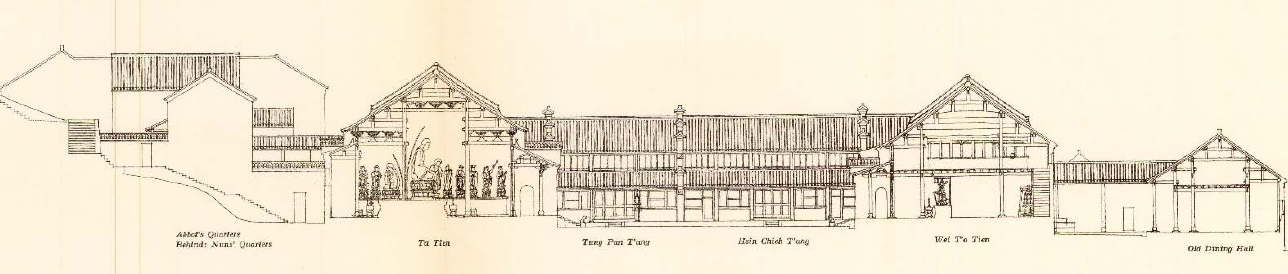
Figure 10. Section of Longchang Monastery, Showing the Main Hall, the Main Courtyard and the Hall of Weituo (Prip ‐ Møller 1937, Pl. 4).